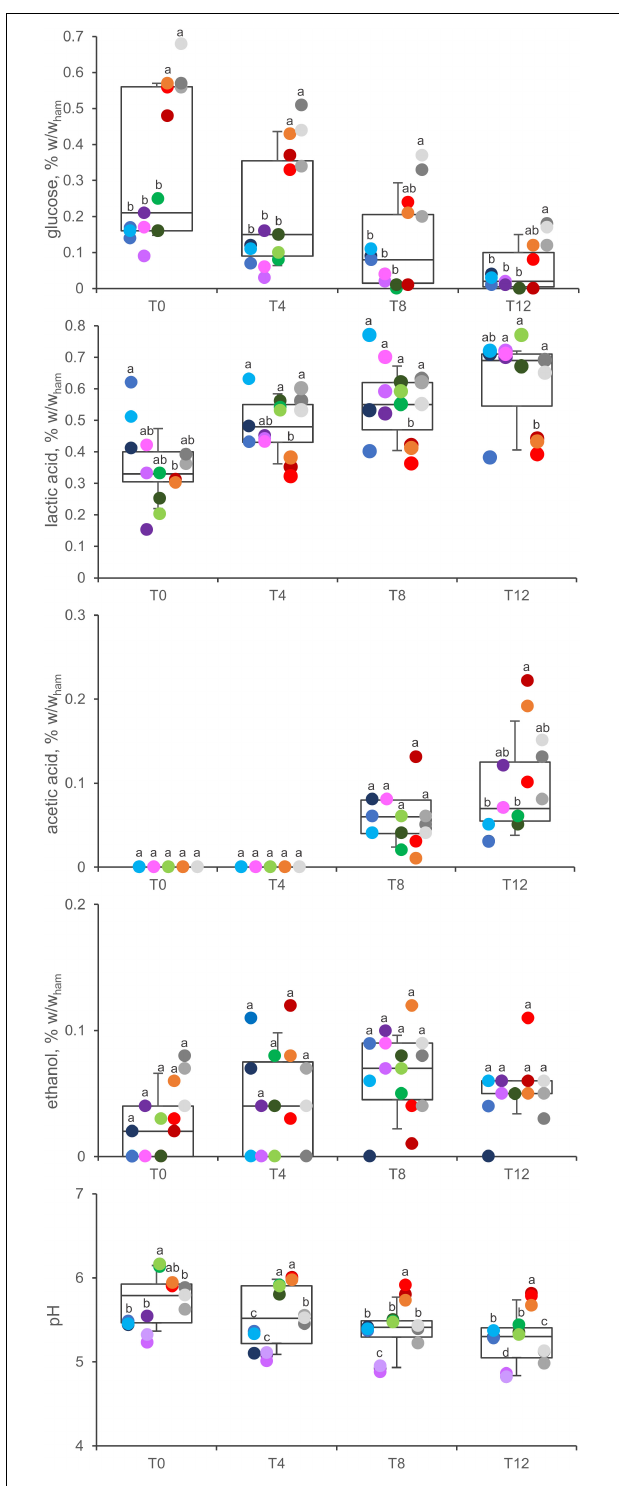
FIGURE 5 | Concentration of glucose, acetic acid, lactic acid, ethanol, and pH variation in A (blue), B (violet), C (green), D (red), and E (gray) samples. Boxes indicate 25th, 50th, and 75th percentiles; whiskers indicate 10th and 90th percentiles. Within each time point, products sharing same letter did not make a significant difference ( p >